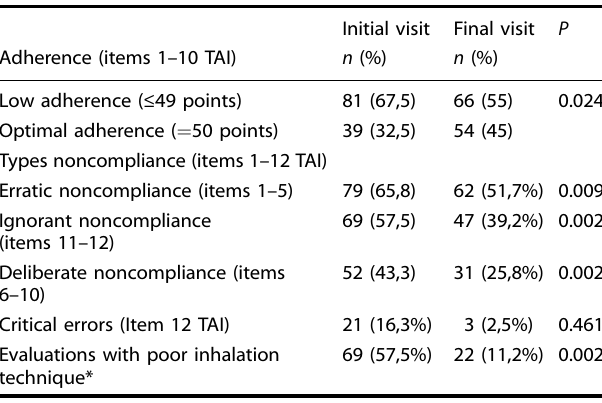
Table 3. Changes in adherence, type of noncompliance and critical errors in initial an fi nal